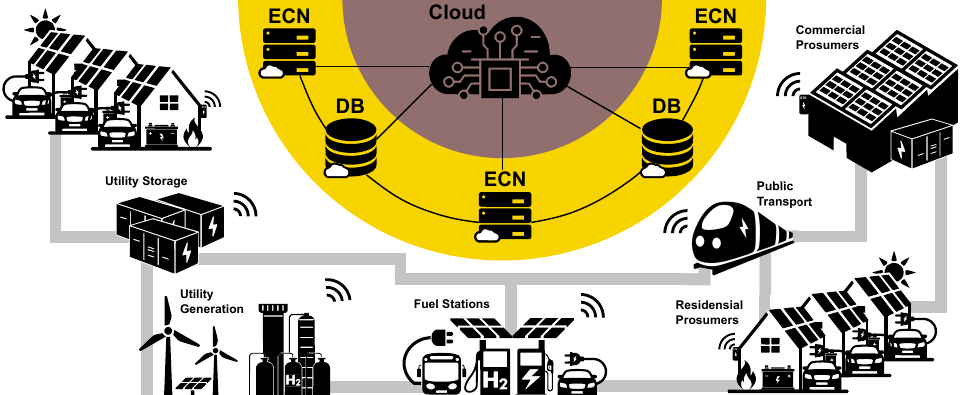
Figure 13. The general idea is to have a network of databases and compute nodes (which includes smart meters) to keep essential local data and computation locally where quick responses and decisions are needed, while the cloud is overseas and sends signals coordinating the system at a higher level. DB: Remote Data Base, ECN: Edge Compute